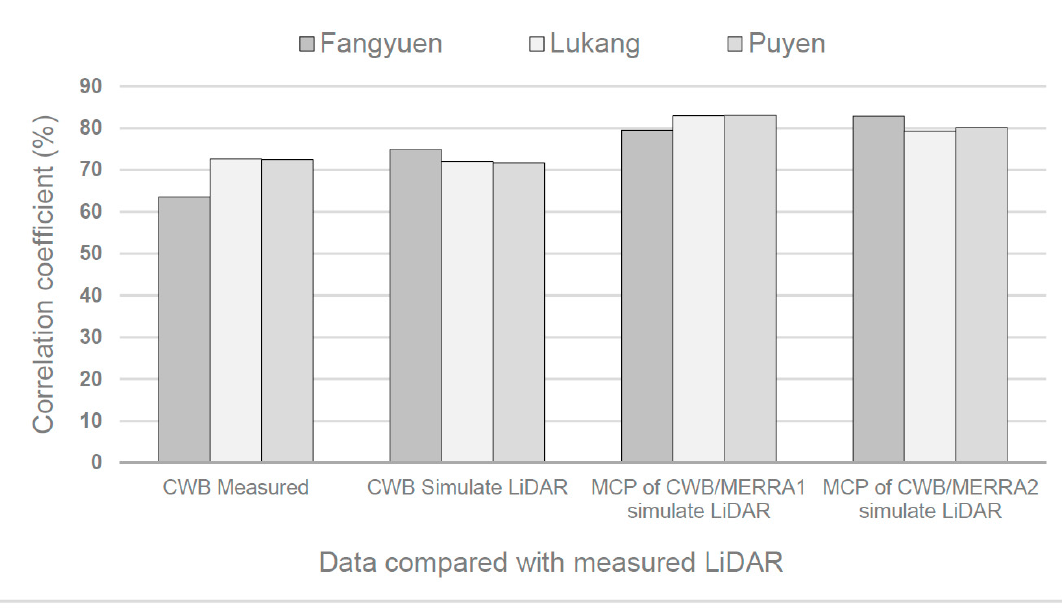
The data from the LiDAR device and mast were processed through the MCP method by using MERRA location 2 data to produce long ‐ term historical wind data for evaluating wind resources and predicting power generation by the Changhua ‐ South Wind Farm. The long ‐ term historical wind data obtained from the LiDAR device and mast for the period between 2008 and 2018 were evaluated using MCP. The data measured by the floating LiDAR device and mast represented the target data of the wind resource, and the MERRA data represented the reference data. The Weibull distribution and wind direction of the wind resource for the CWB, LiDAR device, and mast after using MCP are discussed as follows. 3.1.1. Floating LiDAR Device The Weibull distribution of wind resources at the site of the floating LiDAR device after using MCP is illustrated in Figure 7. The values of the shape parameter ( k ) and scale parameter ( λ ) of the Weibull distribution at the site of the floating LiDAR device were 1.85 and 7.61 m/s, respectively. The wind speed averaged 7.89 m/s and was distributed mainly between 0 and 15 m/s. The wind direction was dominated by north–northeast and north winds, followed by south–southwest wind (Figure 8).